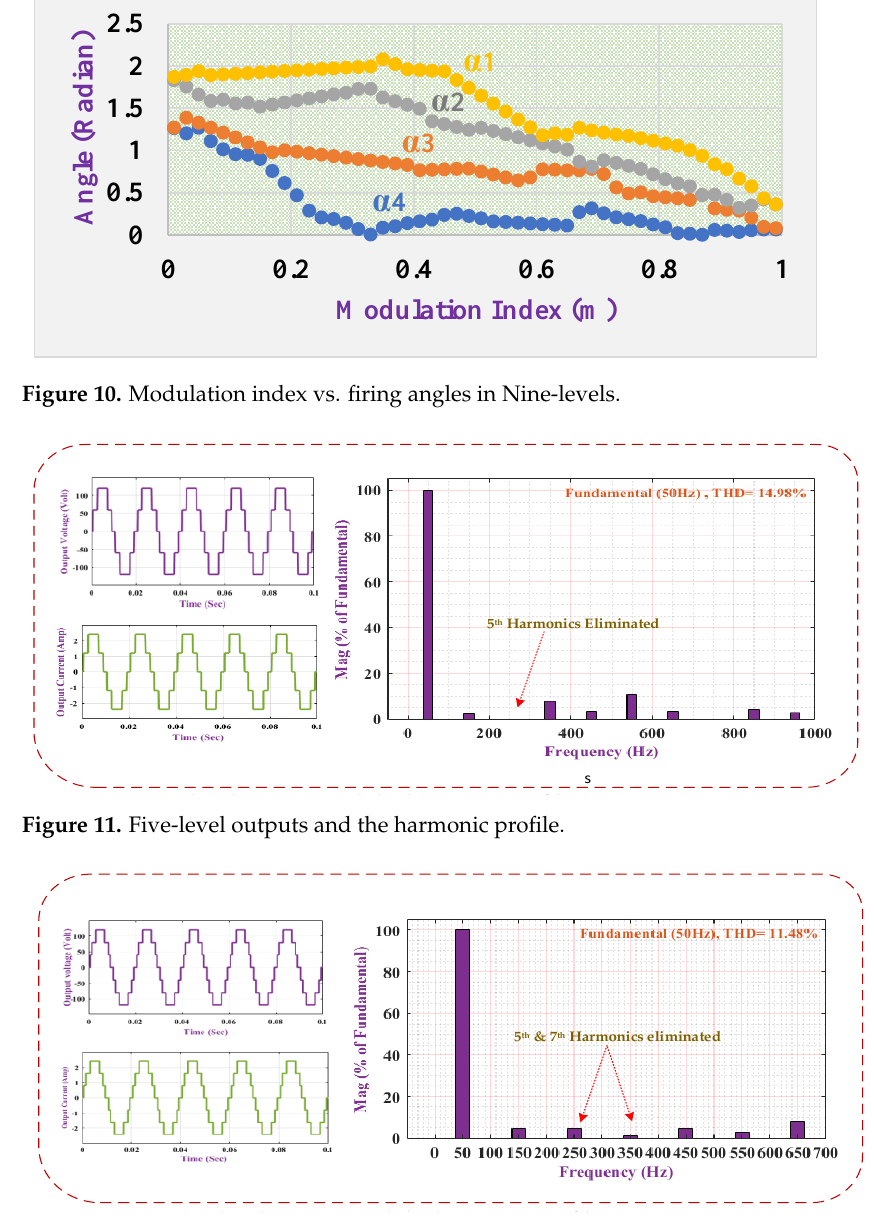
Figure 9. Modulation index vs. firing angles in Seven-levels. Figure 9. Modulation index Vs firing angles in Seven-levels. Figure 9. Modulation index Vs firing angles in Seven-levels. Figure 9. Modulation index Vs firing angles in Seven-levels.